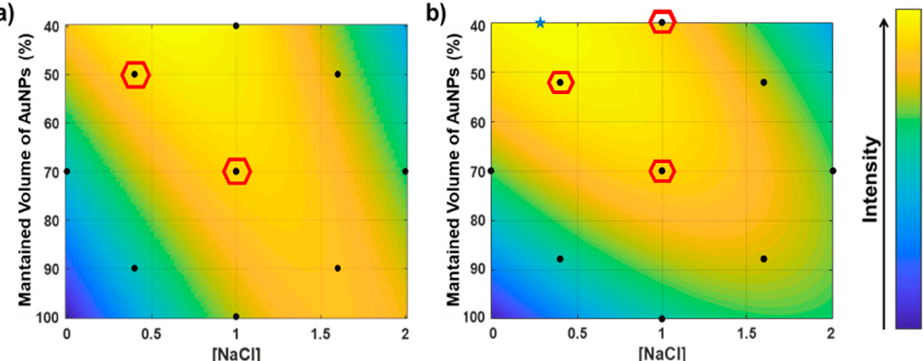
Figure 5. ( a ) Empirical response surface for TMP and ( b ) response surface from Equation (1) for SMX. Experiments with better empirical results are highlighted in red. The blue star is the maximum intensity from Equation (3).